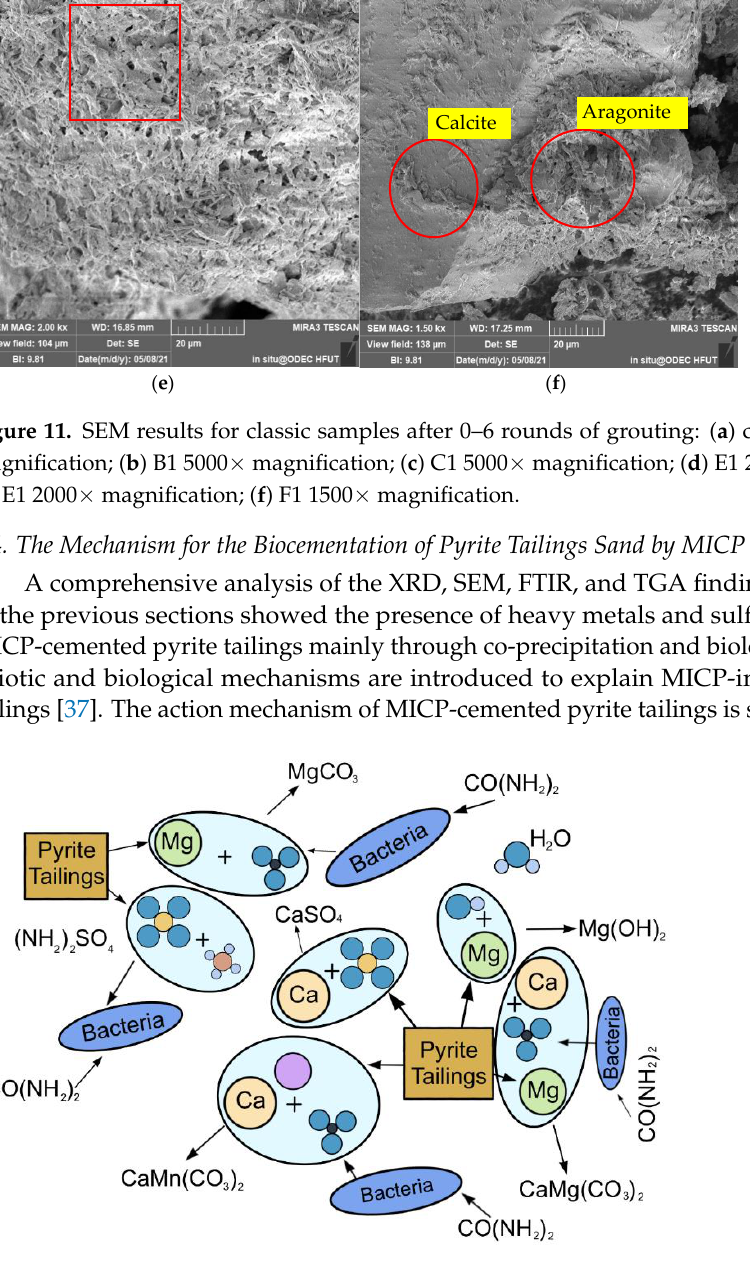
Figure 12. Schematic diagram of the mechanism of MICP solidified pyrite tailings.